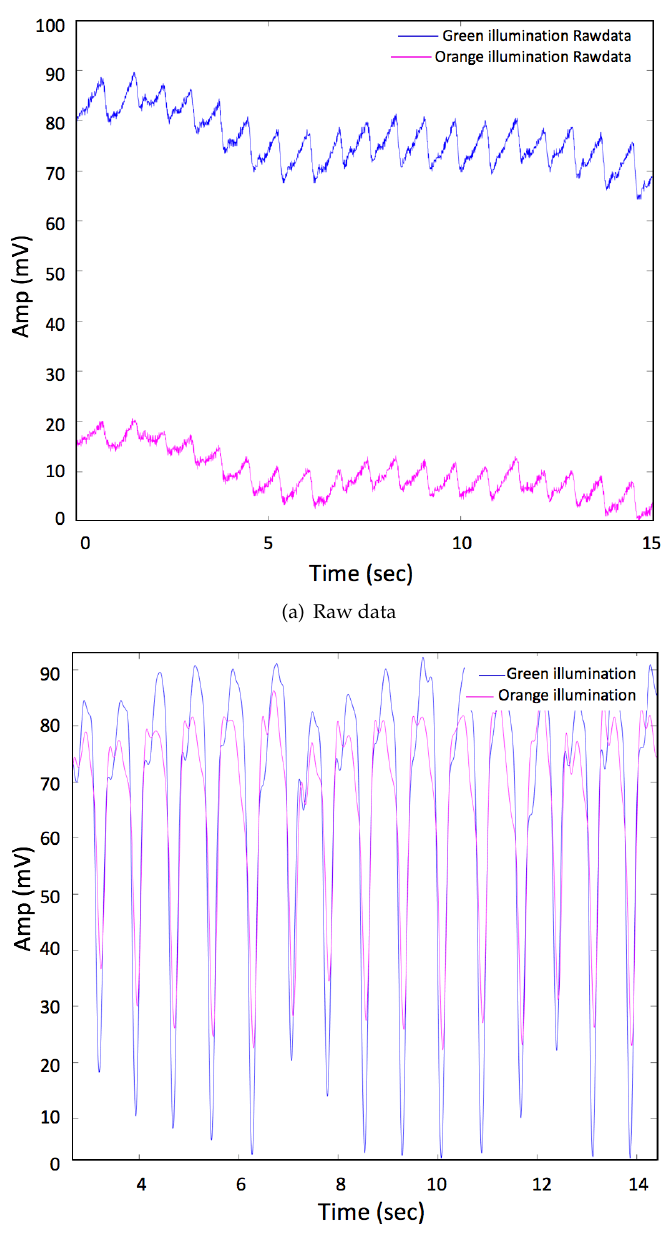
Figure 3. Data obtained from the mOEPS system ( a ) the raw green and orange signals; ( b ) the signals from the four wavelength illuminations after the band pass filtering (0.8–5 Hz). The peaks and troughs in the signals can be used to obtain SpO 2